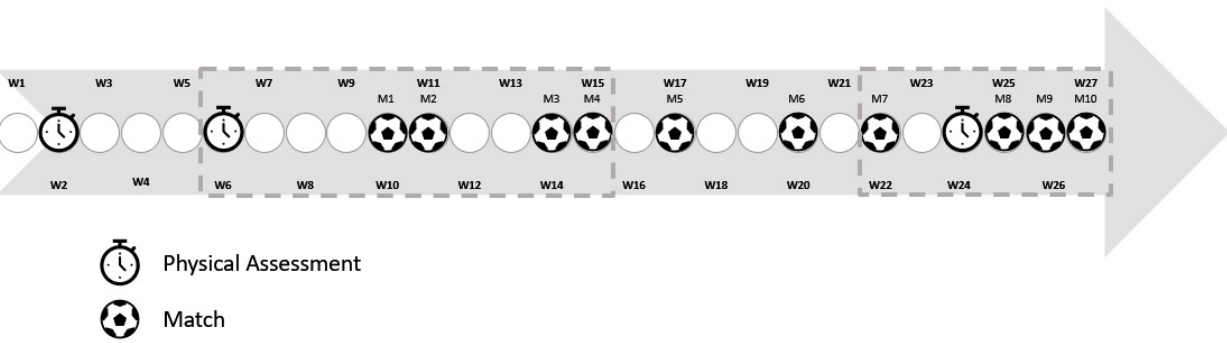
Figure 1. Timeline of the study.